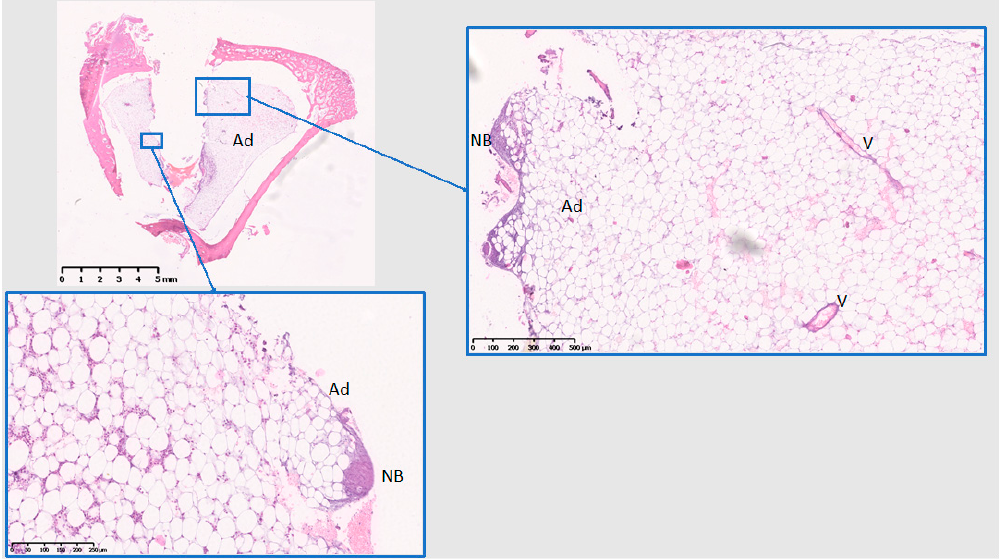
Figure 13. Histological analysis of PEEK (28 days). Ad: Adipose tissue; V: blood vessels; NB: New bone. Mostly adipose tissue proliferation and the bone tissue in the threads has not matured, nor calcified substantially. Scale bars : 5 mm, 500 µm, and 250 µm.